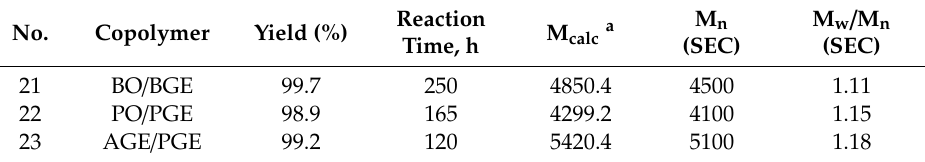
Table 6. Characterization of copolyether-diols by SEC technique.